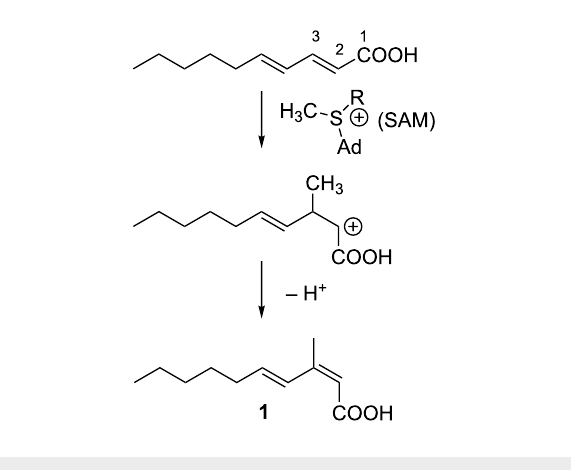
Scheme 3: Possible methylation mechanism for compound 1